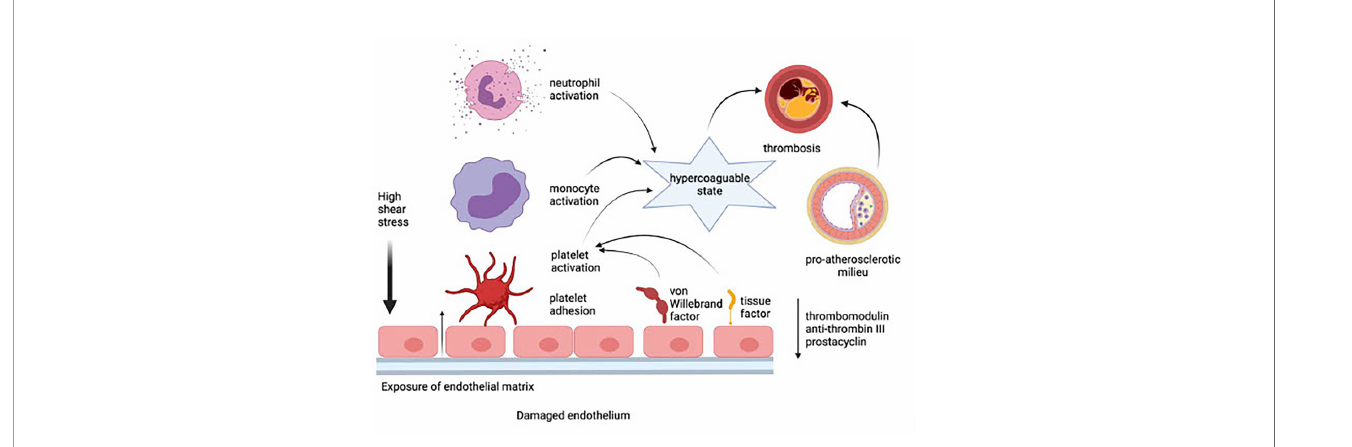
FIGURE 1 | Adverse consequences of a damaged endothelium (created in Biorender). In the setting of high shear stress, exposure of the sub-endothelial extracellular matrix leads to the loss of endothelial cell-derived anti-coagulant proteins such as thrombomodulin and anti-thrombin III, as well as the prostanoid, prostacyclin. Platelets are activated via endothelial leakage of von Willebrand factor and by increased synthesis and expression of tissue factor by endothelial cells. Platelet accumulation and interaction with monocytes and neutrophils potentiate a hypercoagulable state, which, in the presence of a pre-atherosclerotic milieu, causes thrombosis and predisposes for development of myocardial infarction and